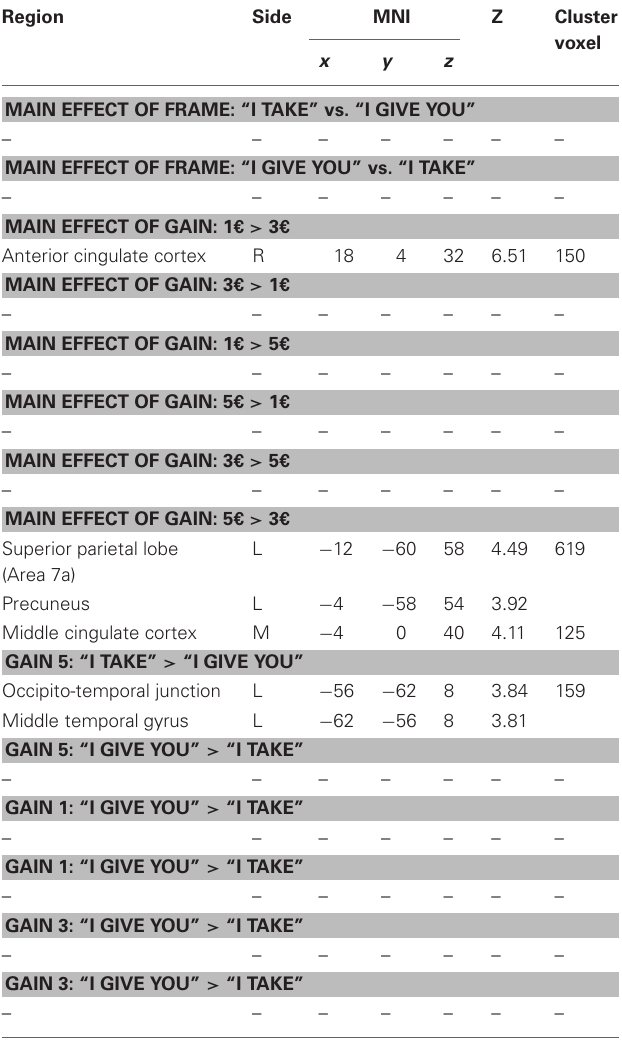
Table 2 | Whole brain analysis for the model accounting for frame and The frame × response type interaction contrast included also for gain effects: brain regions showing significant relative increases the fair C5 offers. We ruled out the possibility that the fair C5 of BOLD response associated with the experimental conditions. offers drove the effect, since the rejection rates for fair C5 offers in the “I take” frame did not significantly differ from the frame Region Side MNI Z Cluster “I give.” We also would like to argue that gain 5C, being the most voxel equal gain, is the condition that more than the others shows the x y z frame effect: precisely because it is an equal and fair offer, the effect of frame should be null. Instead, we found that the activa- tion in the OT junction was significantly modulated by the effect of frame for fair, C5